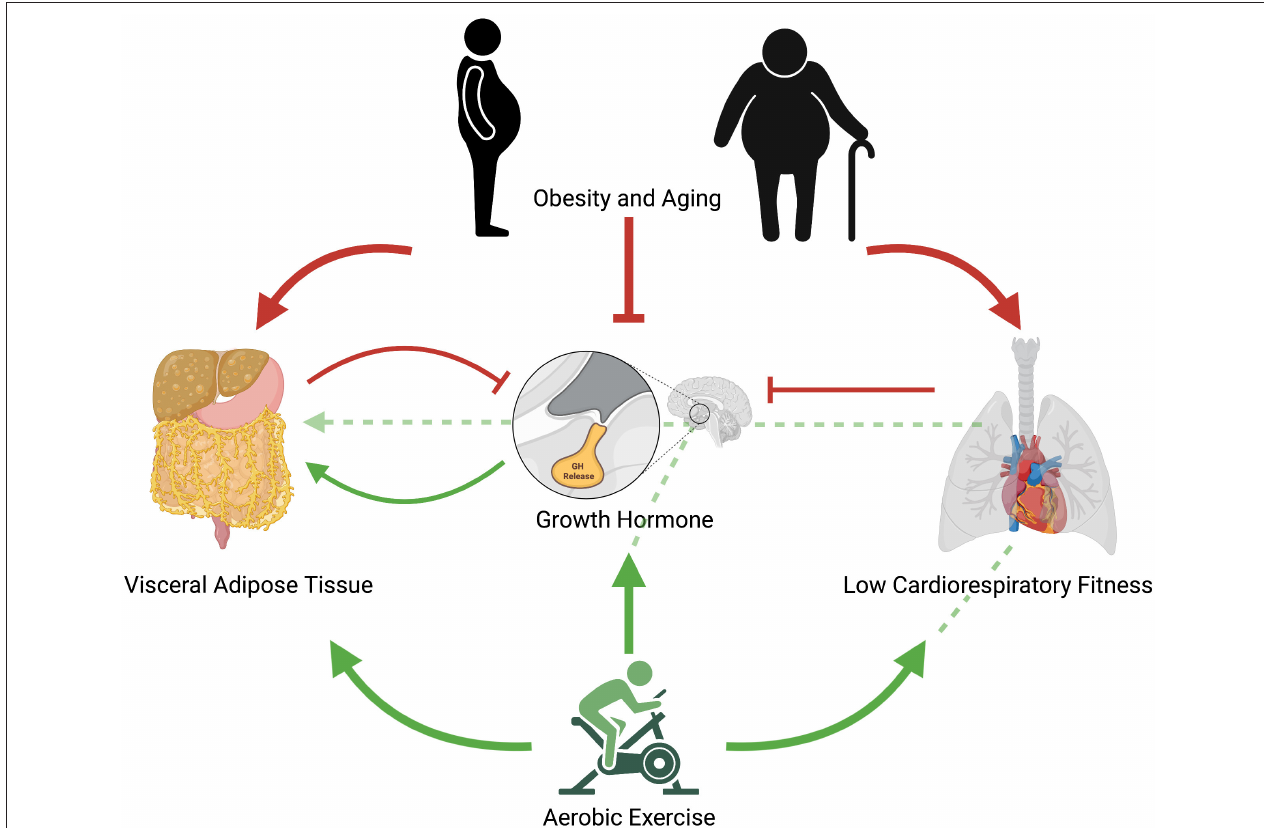
FIGURE 1 | Proposed mechanistic pathway for aerobic exercise induced changes in growth hormone release and ensuing reductions in visceral adipose tissue. Red arrows represent negative effects; green arrows represent positive effects; unbroken red lines represent inhibitory effects; broken green lines represent potential positive pathways of exercise-induced improvements in cardiometabolic health. Obesity and aging contribute to increased visceral adipose tissue, reduced cardiorespiratory fitness, and impaired growth hormone release. Low cardiorespiratory fitness further contributes to impaired growth hormone release as does visceral adipose tissue. Regular aerobic exercise reduces visceral adipose tissue, increases growth hormone release, and increases cardiorespiratory fitness. Regular aerobic exercise may also indirectly improve visceral adipose tissue through increases in cardiorespiratory fitness, which lead to improved growth hormone response and ensuing interactions in visceral adipocytes. Acute aerobic exercise elicits growth hormone release, which increases lipolysis of visceral adipose